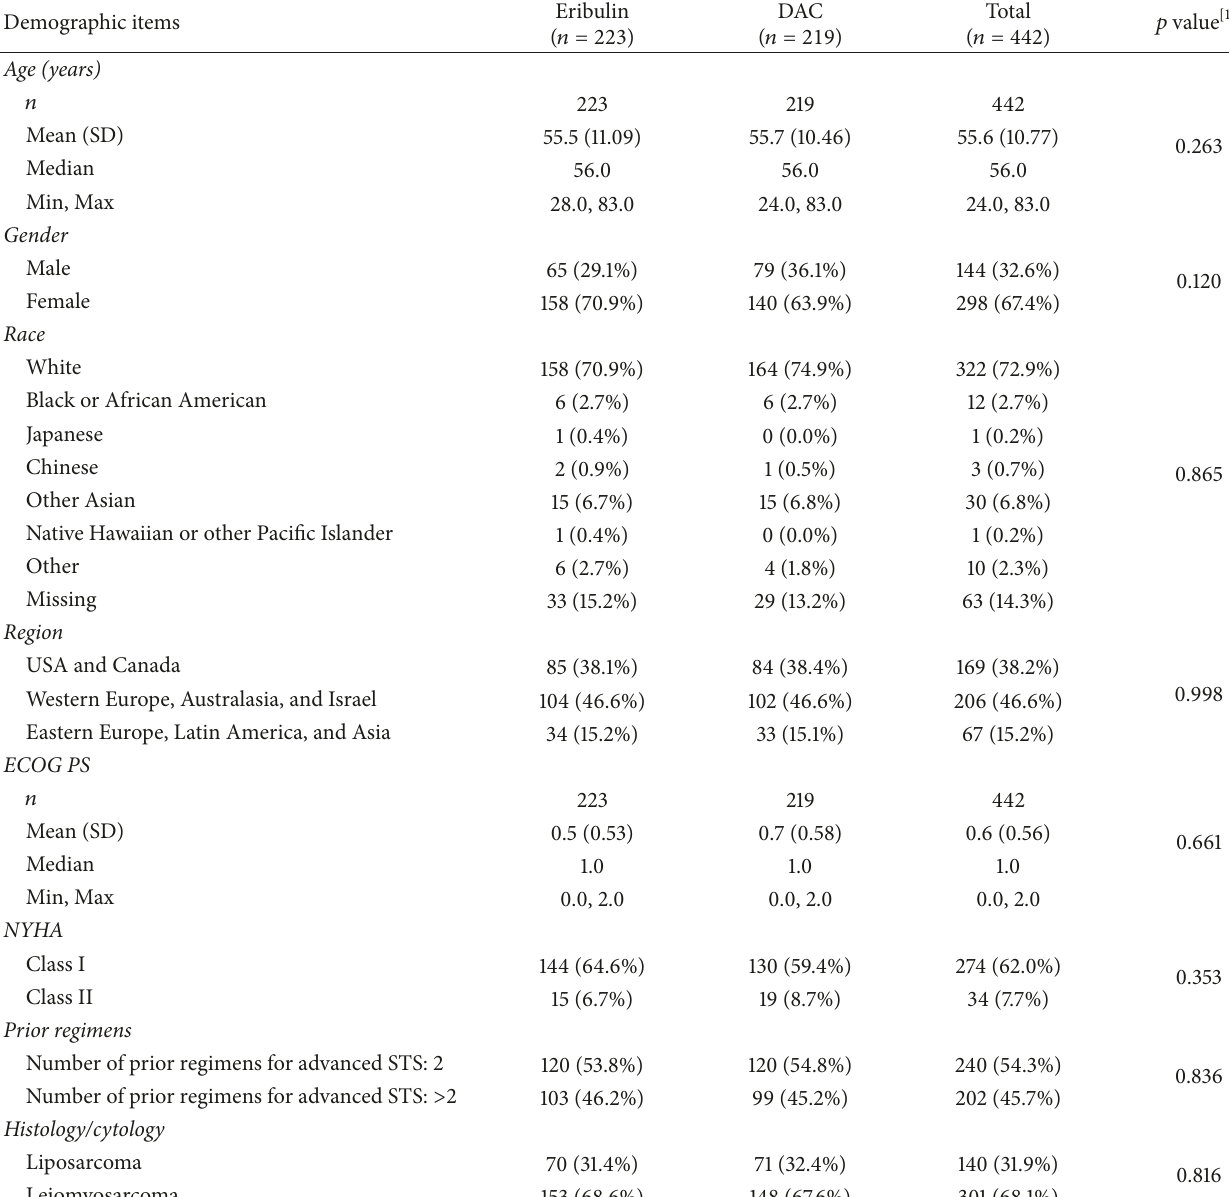
Table 1: Patients’ baseline characteristics of cross-sectional population for QoL